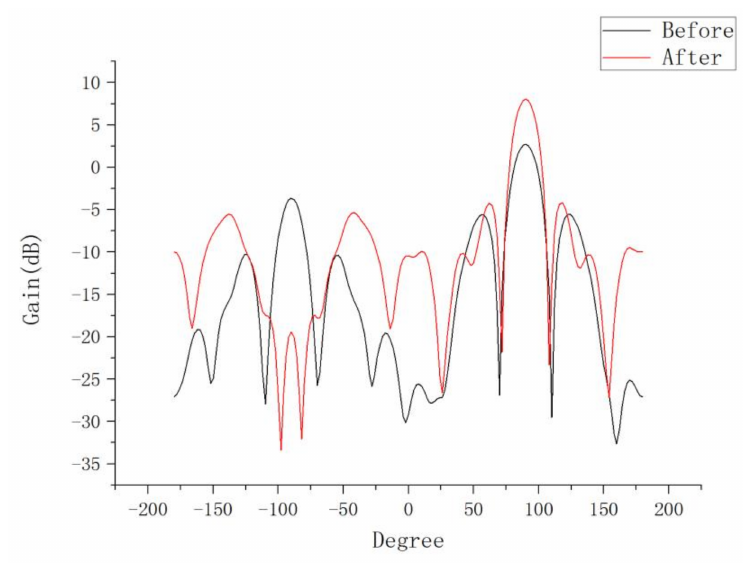
Figure 10. Performance comparison before and after